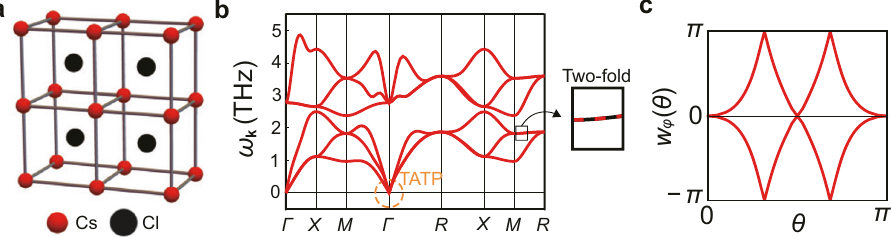
Fig. 2 TATP in CsCl. a CsCl lattice structure. b Phonon spectrum ( ω k ) of CsCl along the high-symmetry lines obtained by fi rst-principles calculations. Acoustic phonons at Γ carry q ¼ ð 1 ; 2 Þ . q cannot be de fi ned for the triple degeneracy at the R point, because lower two bands cannot be fully separated from the highest energy band owing to the degeneracy between upper two bands along the RM direction. c Wilson loop spectrum of the two lowest acoustic phonons near the Γ